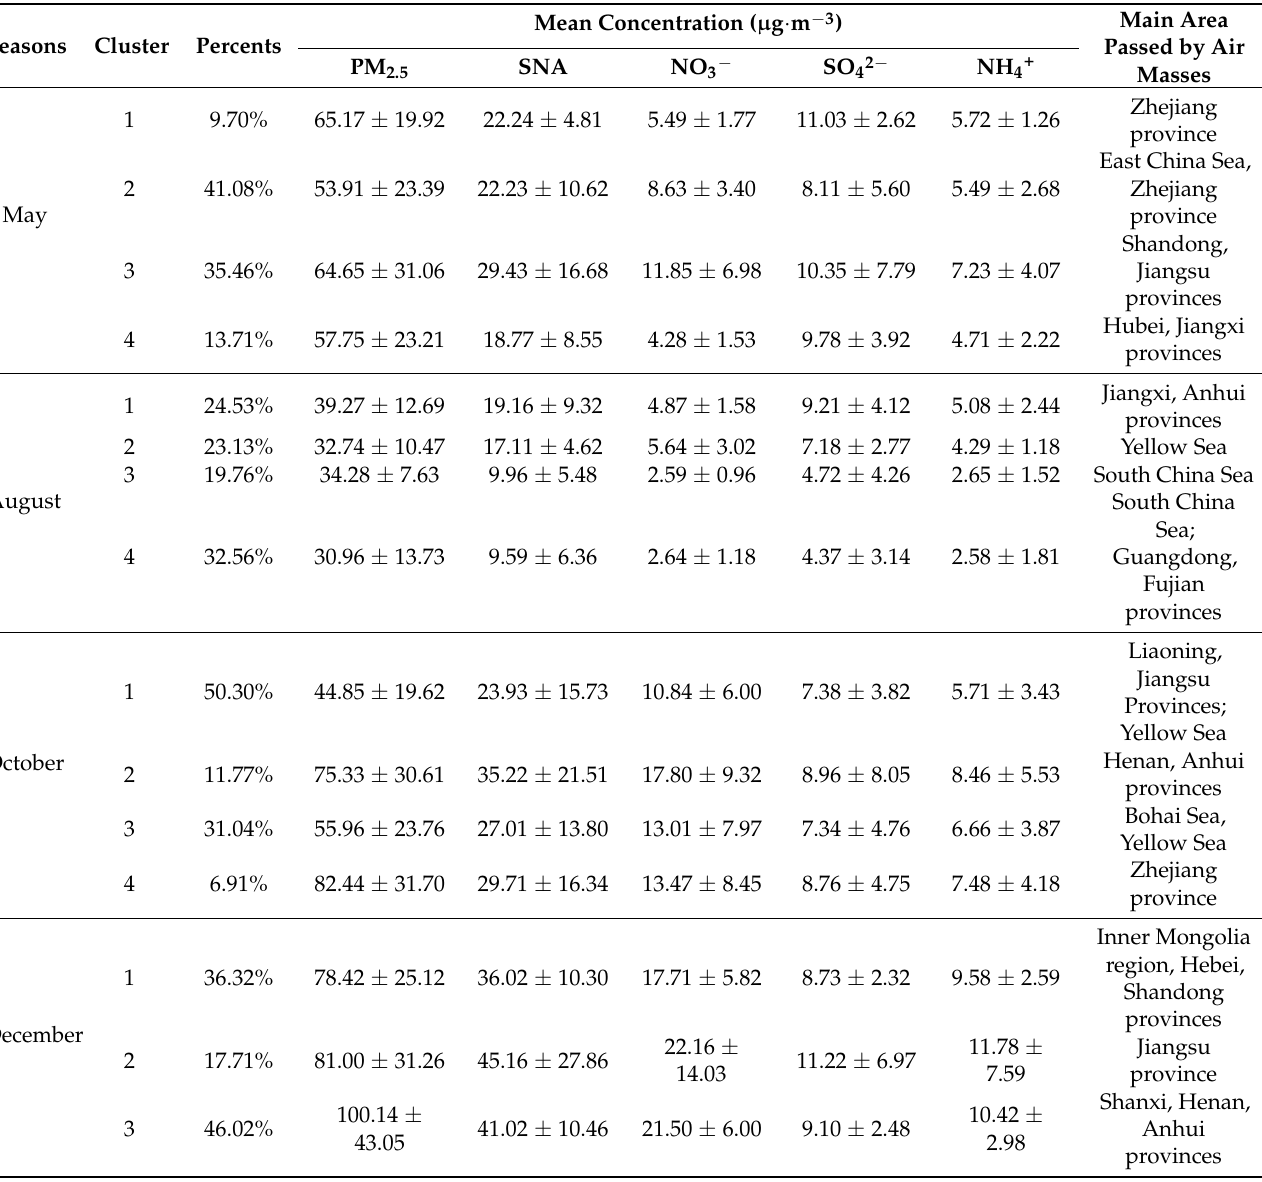
Table 3. Percentages of trajectories, mean concentrations of PM 2.5 , SO 42 − , NO 3 − and NH 4+ for each trajectory cluster in May, August, October and December (see Figure